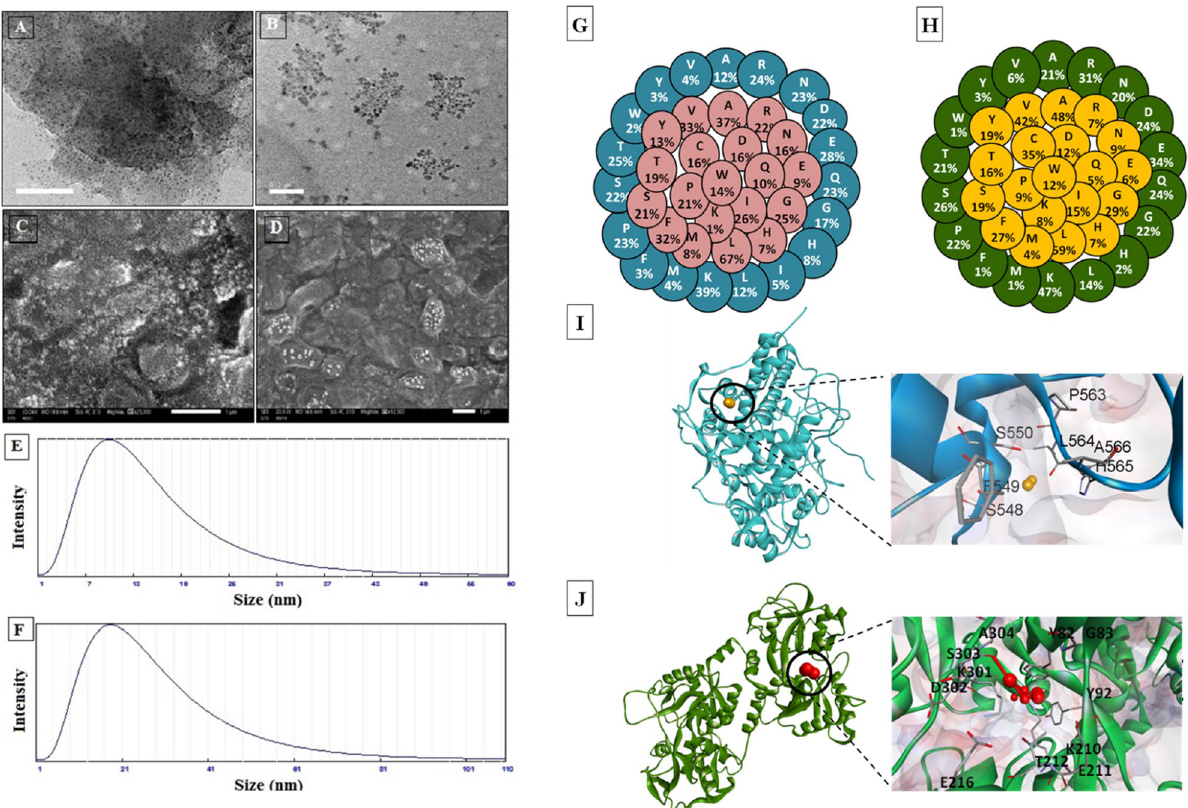
Figure 1. Characterization of nanofabricated LP and LF with hybrid Fe and Cu-NPs. ( A , B ) SEM micrographs of the nanofabricated LP with CNPs (LP-CNPs) and LF with FNPs (LF-FNPs), respectively. ( C , D ) TEM micrographs of the prepared LP-CNPs and LF-FNPs, respectively. ( E , F ) particle size distribution at angle 11.1° of the prepared LP-CNPs- and LF-FNPs, respectively. ( G , H ) Predicted exposed and buried amino acid residues in LP (Accession: AAA62714, 712 amino acids) and LF (Accession: AAA30610, 708 amino acids) via the DeepREx-WS webserver (https:// deepr ex. bioco mp. unibo. it). ( I , J ) The LP-CNPs (LP "blue cartoon" with CuO "orange space-filling spheres style") and LF-FNPs (LF "green cartoon" and Fe 3 O 4 "red space-filling spheres style") docked complex structures, respectively, as provided by the HDOCK server (http:// hdock. phys. hust. edu. cn/) and were visualized by Discovery Studio 2020 Client software 20.1 (https:// www. 3ds. com/ produ cts- servi ces/ biovia/ produ cts/ molec ular- model ing- simul ation/ biovia- disco very- studio). The magnified regions are referred to as the interacting residues with CuO or Fe 3 O 4 in the LP-CNPs and LF-FNPs docked complexes,